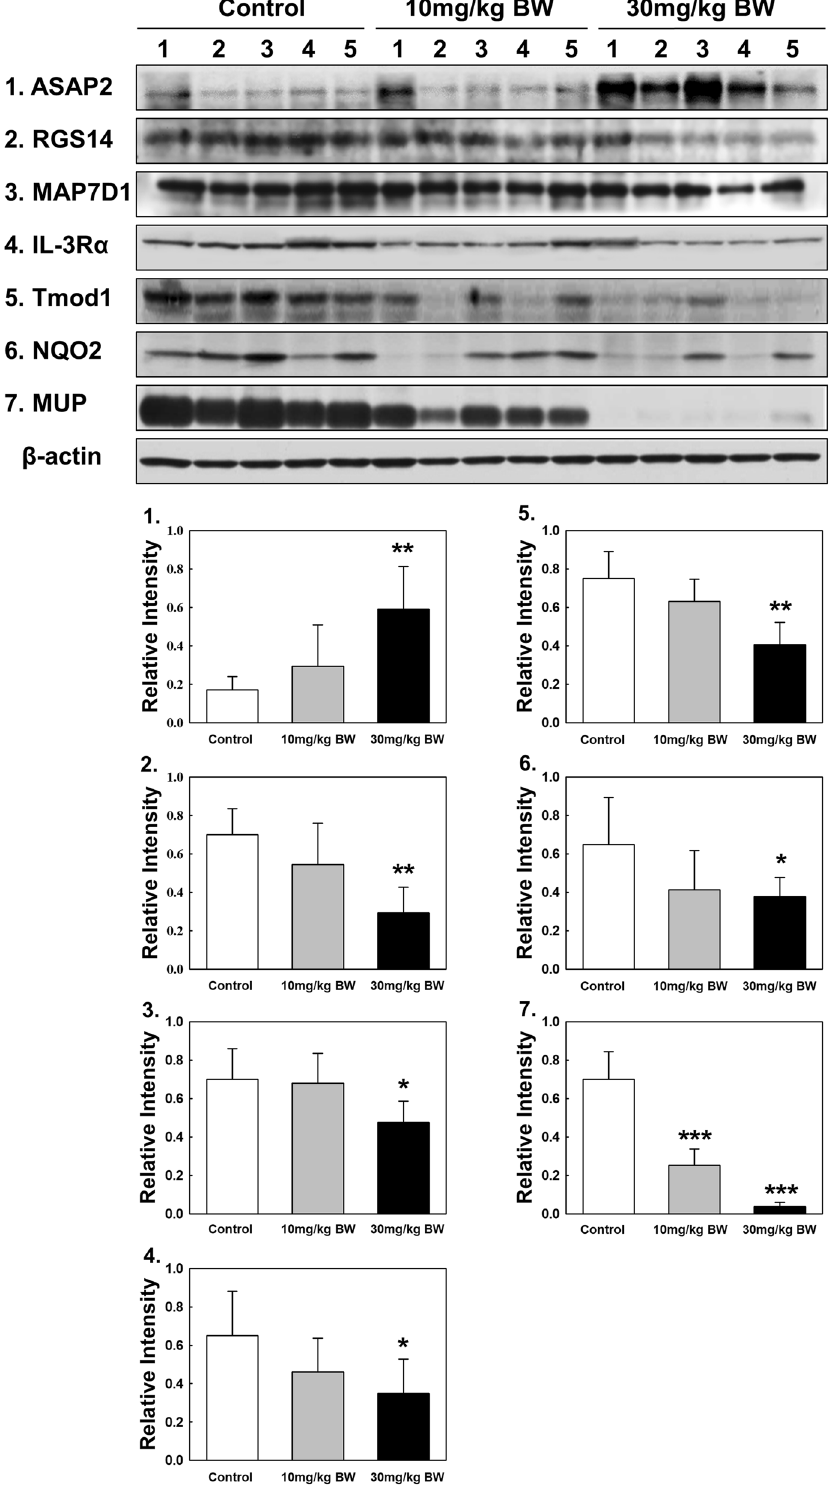
Figure 6. Confirmation of identified proteins by Western blots analysis. (1) ASAP2, (2) RGS14, (3) MAP7D1, (4) IL-3Rα, (5) Tmod1, (6) NQO2, and (7) MUP. Original blots are presented in Supplementary Western blot data. In Western blot analyses, protein samples were subjected to SDS-PAGE with a Western blot kit. Proteins on gels were then transferred onto PVDF membranes. PVDF membranes containing all protein bands were cut prior to hybridization with antibodies. Quantities represented by the gel bands are expressed as intensity relative to β-actin. All relative intensity results are presented as the means ± SD of five experiments. *, **, and *** indicate p -values of 0.05, 0.01, and 0.001, respectively compared to the